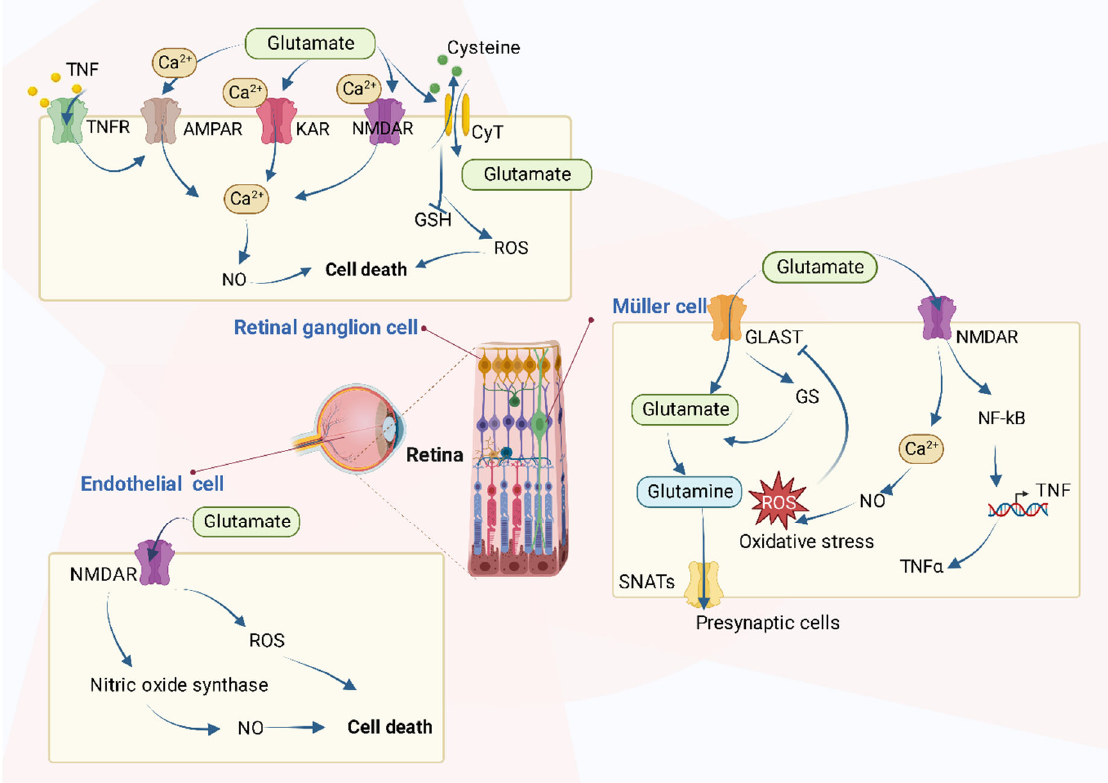
Figure 4. The roles of glutamate on retinal cells. Several types of cells are referred to, including retinal ganglion cells (RGCs), Müller cells, and retinal endothelial cells. In RGCs, excessive glutamate triggers intracellular metabolism changes such as the increase of intracellular Ca 2+ levels through the over ‐ activation of various receptors and causes cell death. In retinal endothelial cells, glutamate increases both NO and oxidative stress. In Müller cells, glutamate causes oxidative stress and increases the production of TNF ‐α .